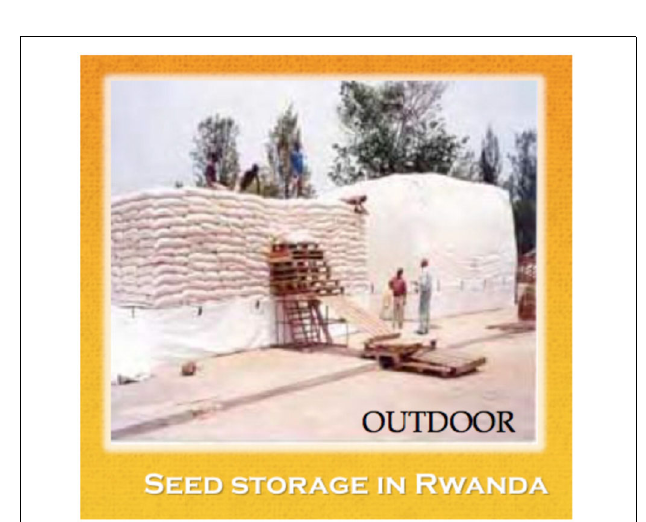
FIGURE 5 | Outdoor seed storage in